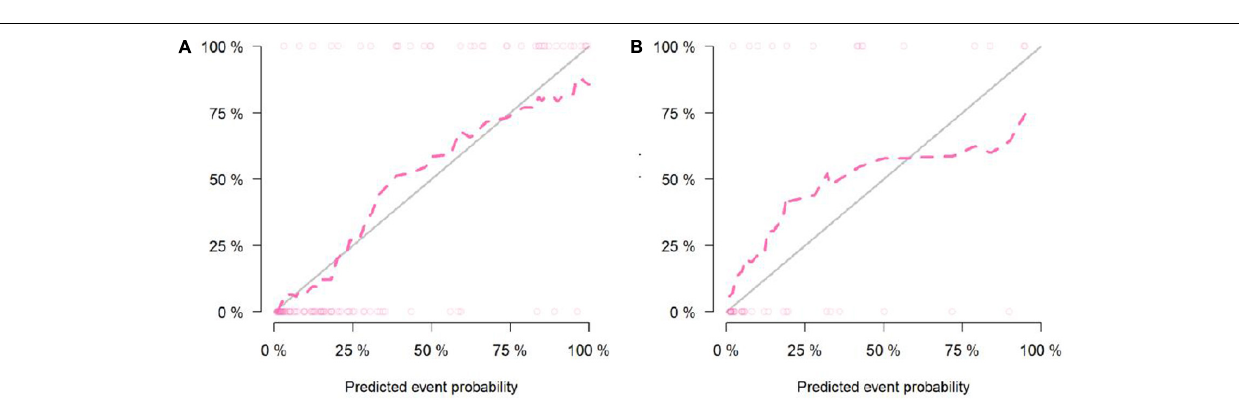
FIGURE 5 | Calibration curve of the Nomogram model in the training cohort (A) . Calibration curve of the Nomogram model in the validation cohort (B)